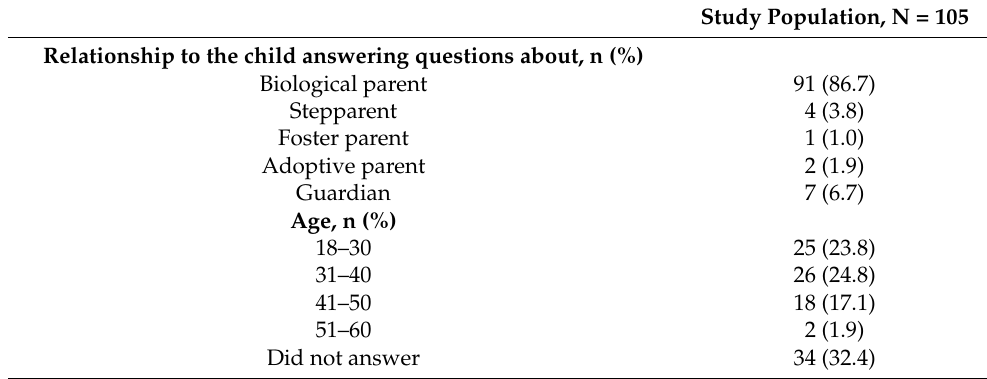
Table 1. Characteristics of caregivers who completed a survey regarding the use of telehealth for their child during the COVID-19